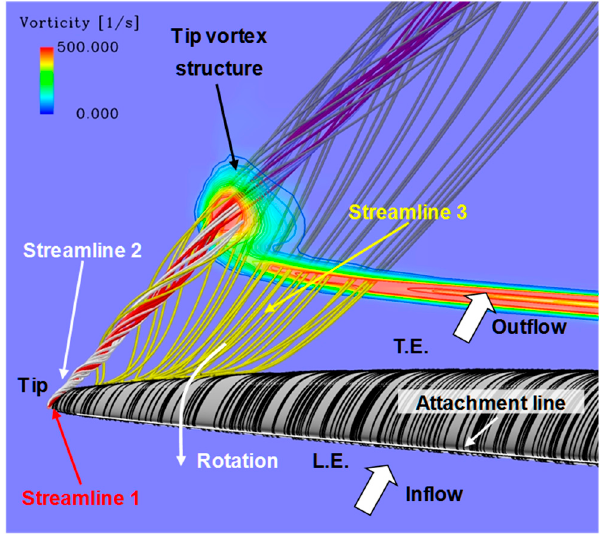
Figure 5. Three-dimensional flow structure of rotor blade tip.